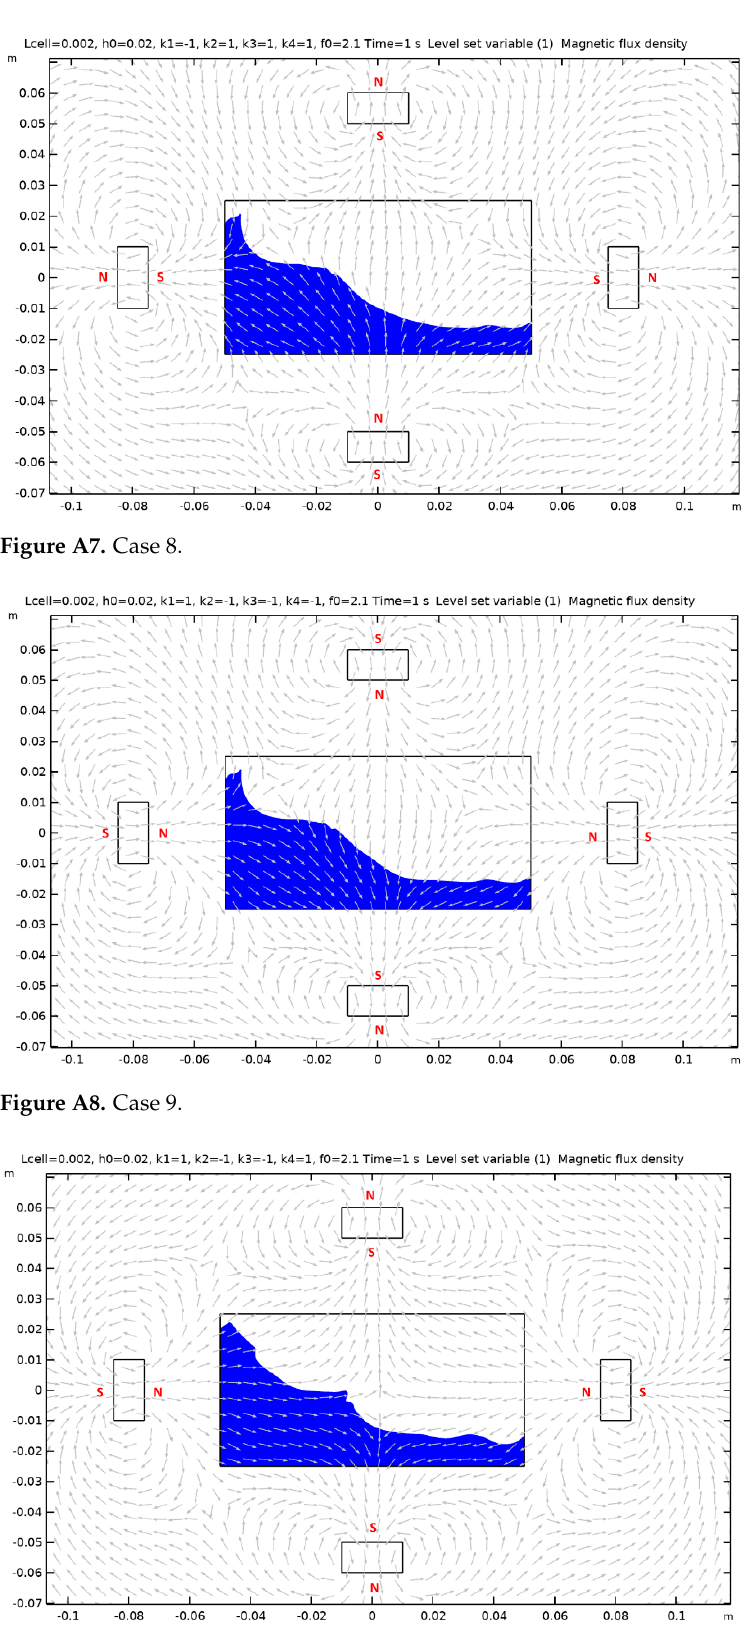
Figure A9. Case Figure A9. Case 10. Figure A9. Case 10.